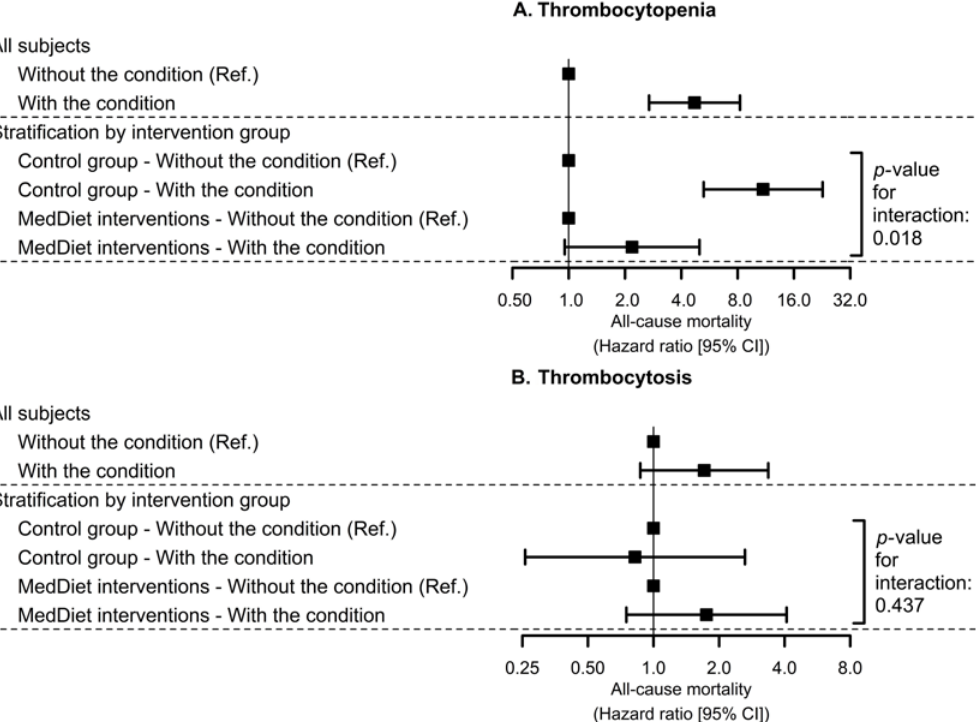
Figure 2. Associations of thrombocytopenia ( A ) and thrombocytosis ( B ) at baseline with all-cause mortality risk stratified by MedDiet groups. Hazard ratios were estimated by multivariable Cox proportional hazards regression models stratified by sex, recruitment site, and educational level and adjusted for age, baseline platelet count, diabetes, hypercholesterolemia, hypertriglyceridemia, hypertension, antiplatelet drug use, smoking habit, white blood cells, leisure-time physical activity, body mass index, intake of alcohol, folates, and iron (at baseline, all), as well as two propensity scores that used 30 baseline variables to estimate the probability of assignment to each of the intervention groups. We used robust standard errors to account for intra-cluster correlations . MedDiet : Mediterranean diet.